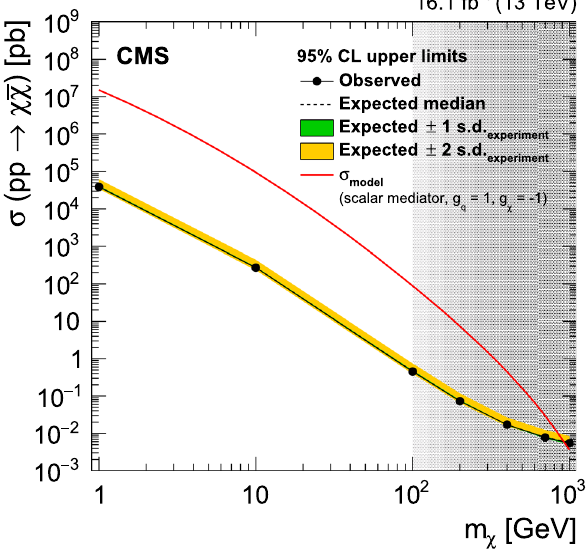
Fig. 11 CrosssectionupperlimitsfortheproductionofapairofSIMPs (represented by χ ) in the context of the CMS search for trackless jets. See text for details. Figure taken from [98]